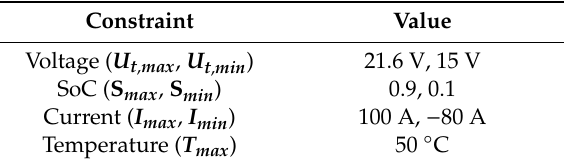
Table 3. Working constraints of the investigated battery pack.